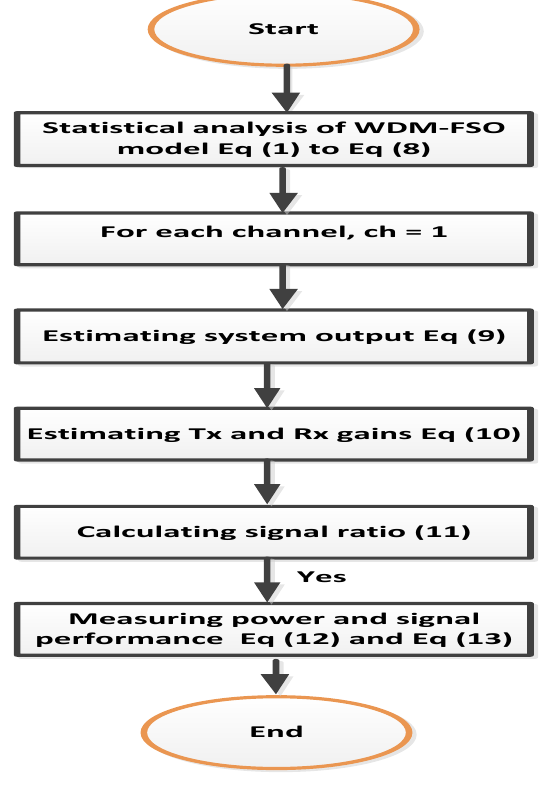
Figure 2. Theoretical model Flow chart for estimating the system